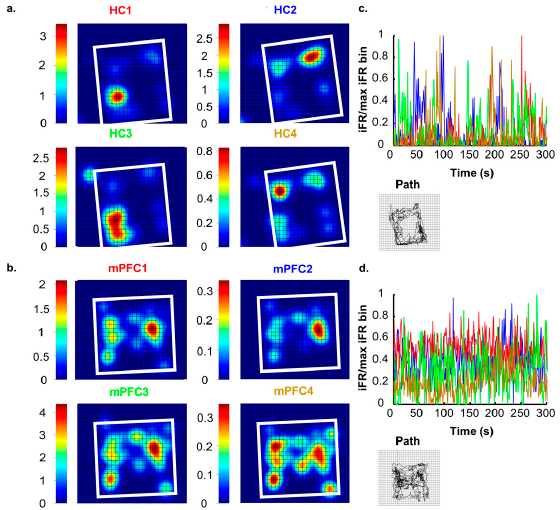
Figure 1. Spatial tuning of hippocampus (HC) & medial prefrontal cortex (mPFC) single-units. ( A , B ) heat relief plots of representative example hippocampal ( a ) and mPFC ( b ) unit firing rates during free exploration. Right, spatial position plots showing animal path during recordings. Note that the firing rate by position plots for hippocampal units all show clear well-defined firing fields, or specific locations within the environment where the cells were selectively active. However, mPFC cells were generally more active throughout the entire environment and thus did not have clear place fields. In fact, the few isolated locations in the environment, where mPFC cells were more active, seemed to merely reflect the amount of time spent in those locations more than anything, as one can see in the XY position traces on the right; ( c , d ) firing rates of example neurons over time . In each plot, normalized firing rates are shown for the four example neurons from the two areas. Time in seconds in the x -axis and proportion of maximum firing is on the y -axis. Line color corresponds to the color of the text above the spatial firing rate plots in ( a , b ). These plots reveal the inherent firing characteristics of cells in the two areas. The sparse coding scheme found in the HC suggests that a large amount of information is stored by single units, whereas mPFC neurons seem to carry very little environmental information scattered over entire ensembles of neurons. Notice how in ( c ), at most points in time, only a single hippocampal cell is active, as only one colored line at a time rises above 0 and the rest are all at or near 0. In addition, note that when cells become active, they tend to fire close to their maximum firing rate. This type of firing is emblematic of a sparse coding scheme, where only a few neurons are part of the information ensemble and each neuron represents highly specified information. Cells in the mPFC on the other hand react very differently. These cells are maintaining elevated firing rates consistently over the entire window, but these rates are most often only ~50% of the maximum